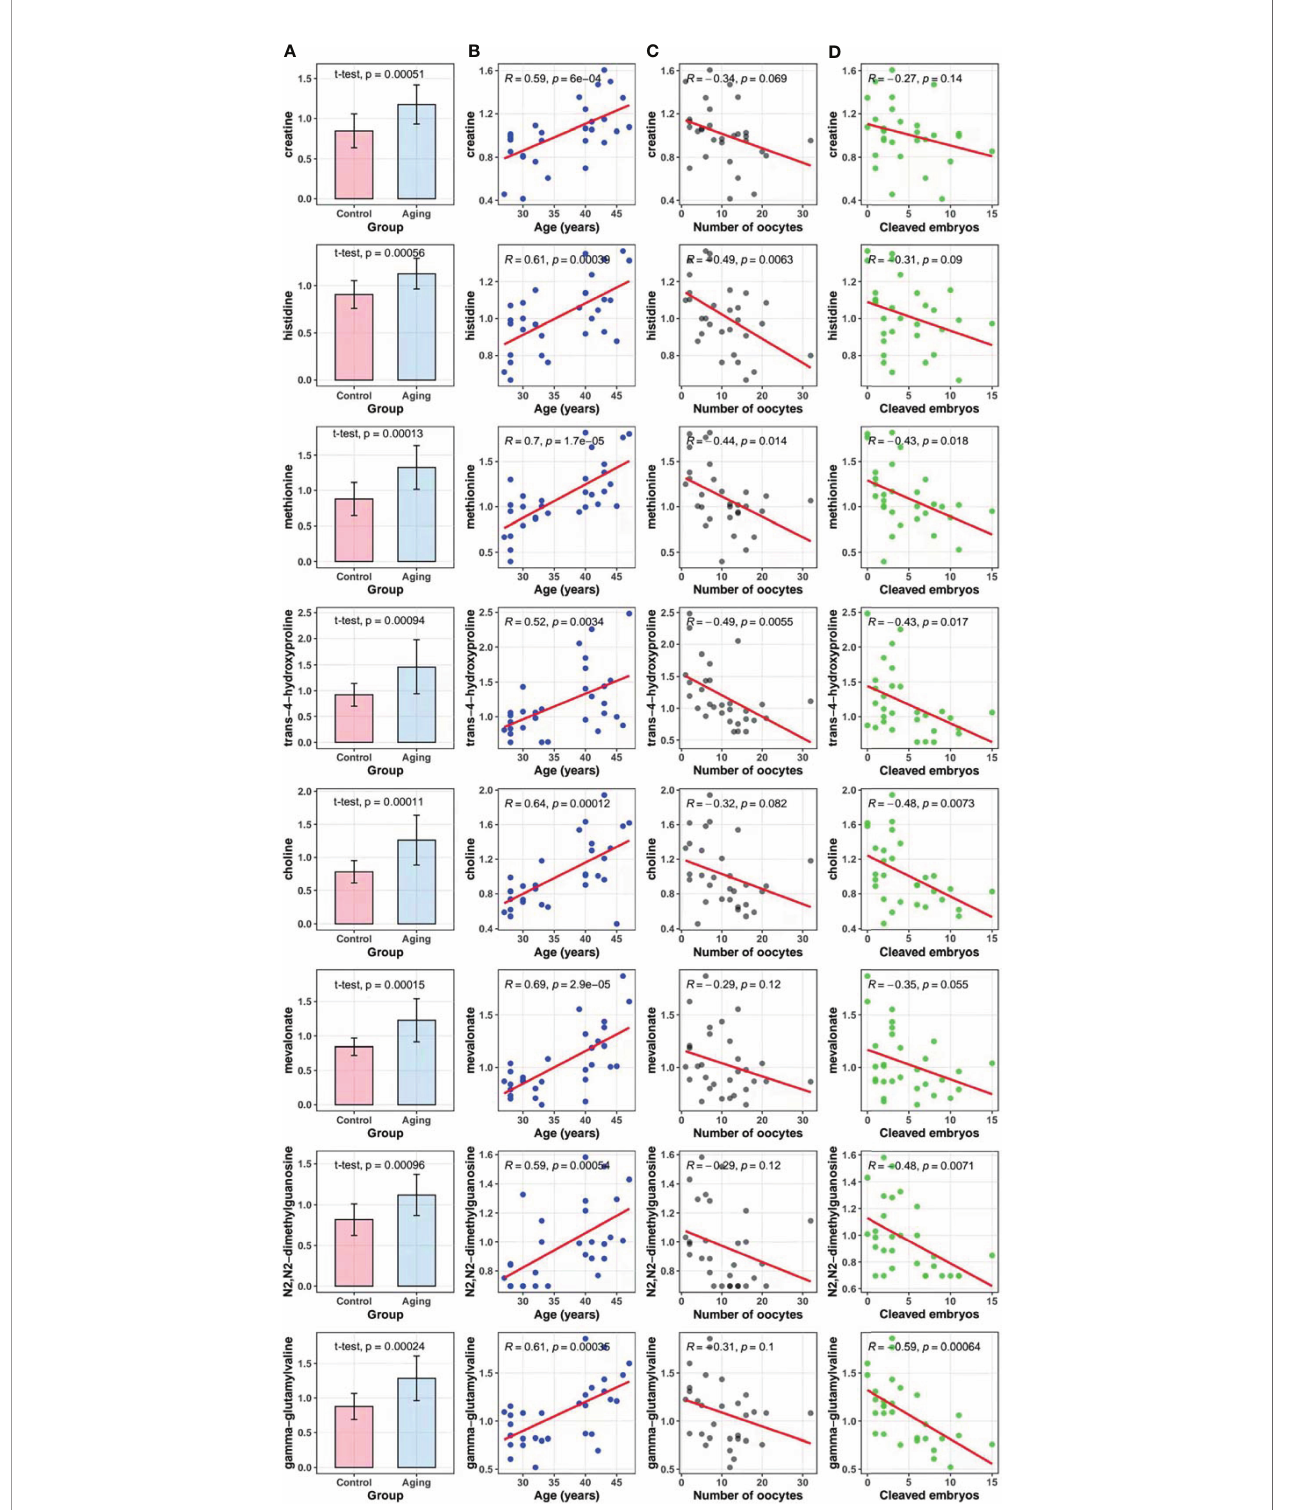
FIGURE 3 | Metabolites in follicular fl uids between the advanced age group and the young age group, and correlation tests of maternal age, the number of oocytes retrieved, and cleaved embryo numbers with metabolites. (A) , Comparisons of the selected metabolites in follicular fl uids between the advanced maternal age group and the young control group (t-test). (B) , Correlations between metabolites and maternal age (Pearson correlation test). (C) , Correlations between metabolites and the number of oocytes retrieved (Pearson correlation test). (D) , Correlations between metabolites and cleaved embryo numbers (Pearson correlation